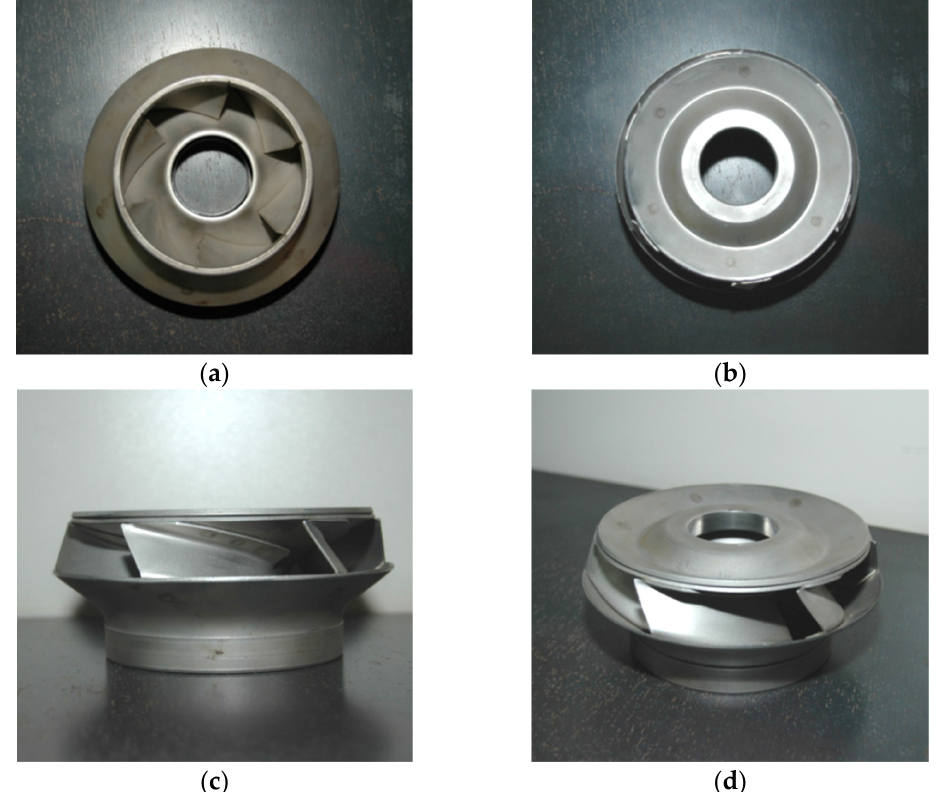
Figure 2. Impeller of the SP 215 pump produced by Grundfos: ( a ) top view; ( b ) bottom view; ( c ) side view; and ( d ) 3D view.